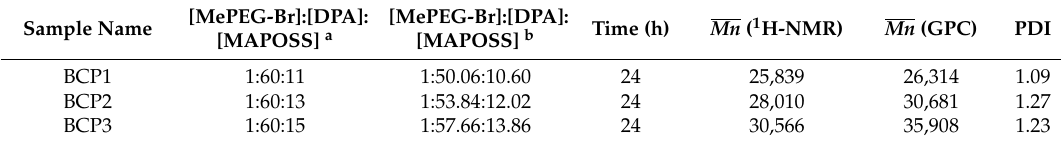
Table 1. Experiments and results of ATRP polymerization of MePEG-Br, MAPOSS and DPA.